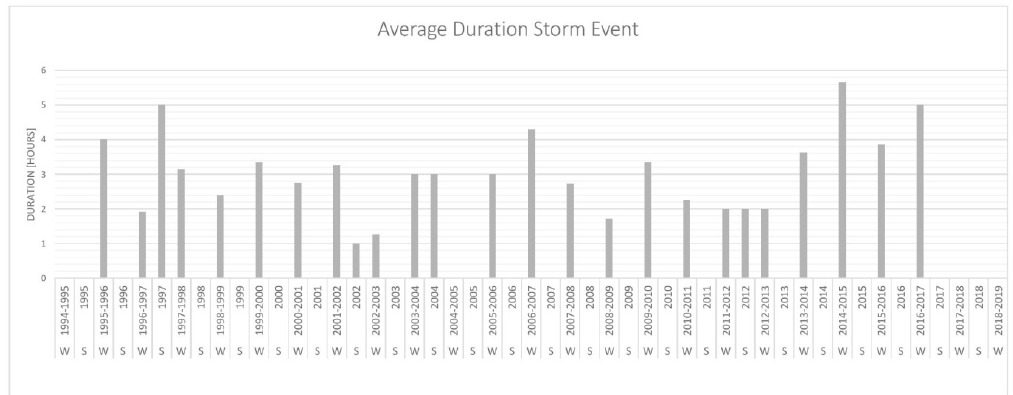
Figure 7. Number of storm events in the preceding 25 years incident on Dingle Bay.